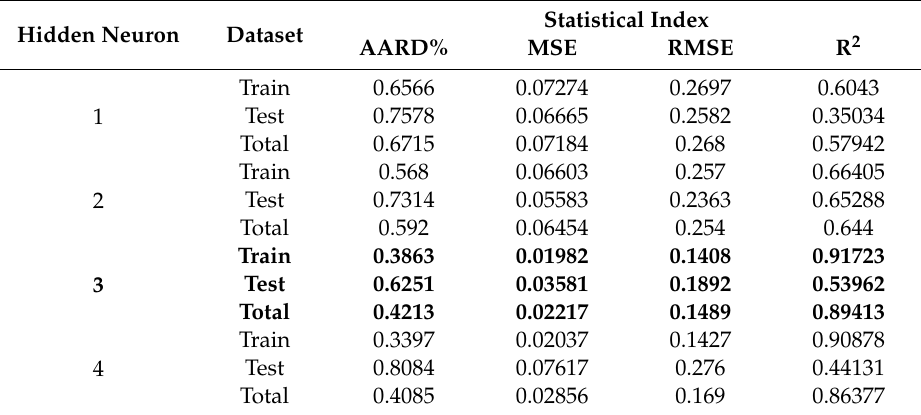
Table 4. The procedure for detecting the best configuration for the MLP